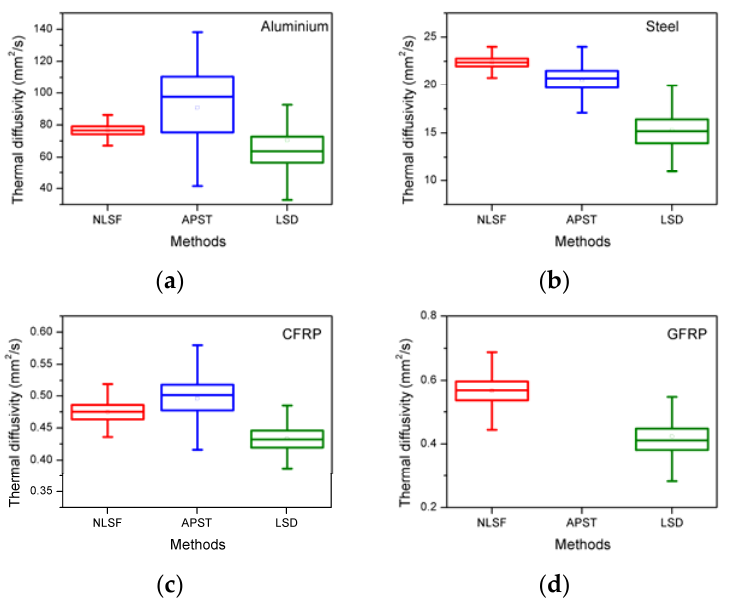
Figure 3. Box charts of the estimated thermal diffusivity (y ‐ axis) for four materials ( a ) Aluminium, ( b ) Steel, ( c ) CFRP, and ( d ) GFRP using the LSD, APST, and NLSF methods (x ‐